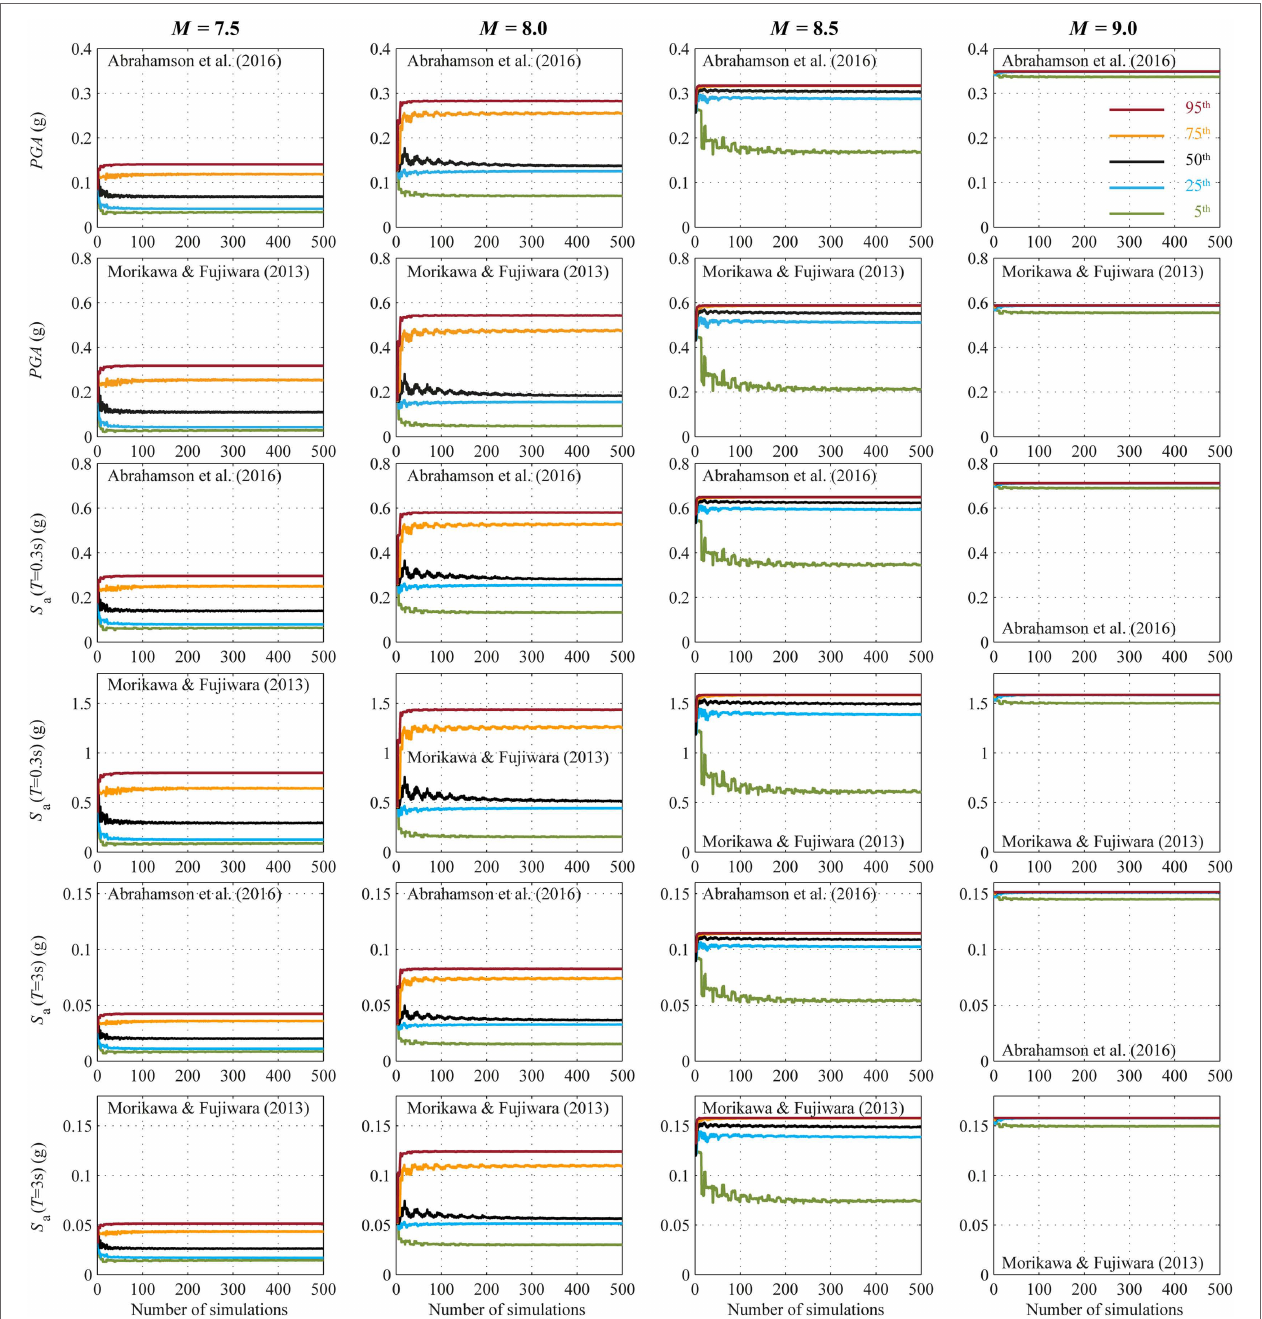
FIGURE 8 | Convergence of estimated seismic intensity measures [i.e., PGA, S a ( T = 0.3s) and S a ( T = 3s)] as a function of the number of simulations by considering the Abrahamson et al. and Morikawa–Fujiwara GMPEs and four moment magnitudes ( M = 7.5, 8.0, 8.5, and 9.0) . Different colors represent different